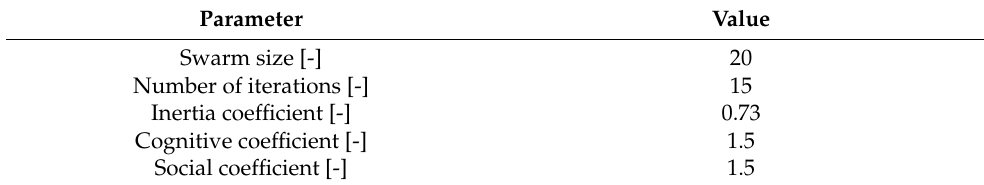
Table 6. Retained PSO